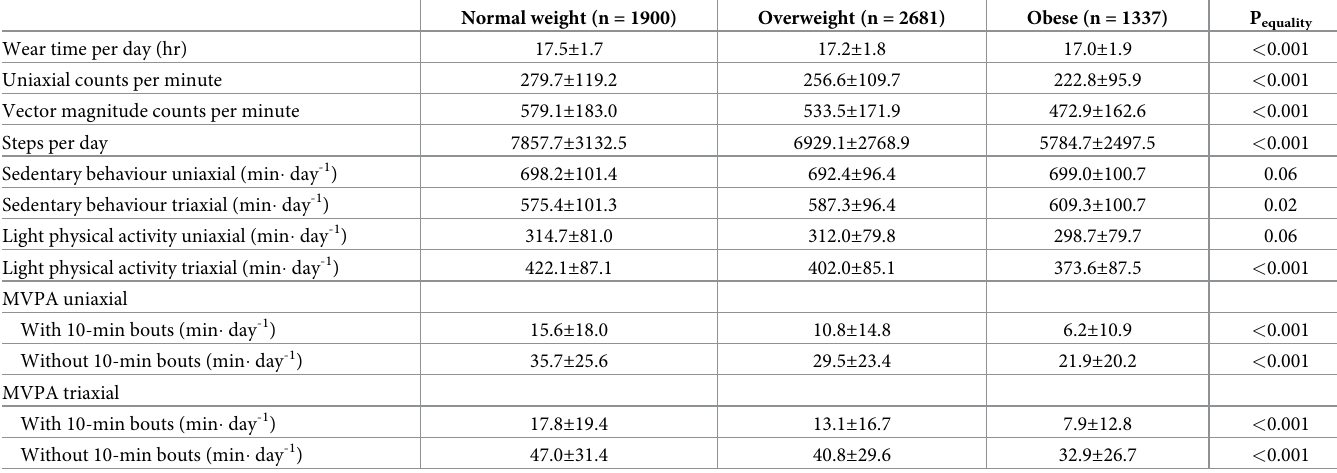
Table 5. Volume measures and intensity specific minutes per day by BMI. The Troms ø Study accelerometry sample